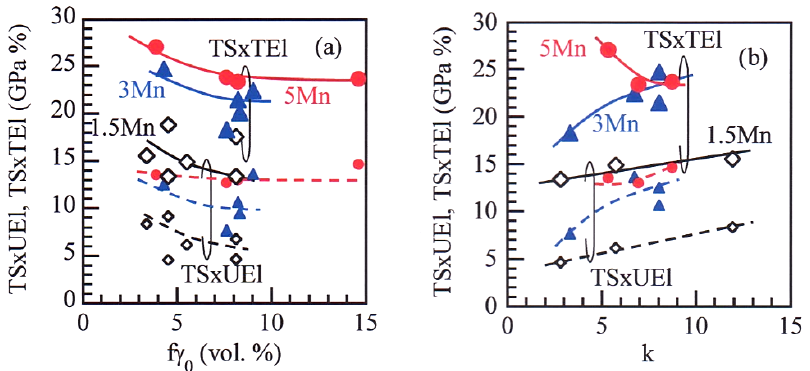
Figure 12. Relationships between TS × TEl and TS × UEl and ( a ) initial volume fraction ( f γ 0 ) and ( b ) strain-induced transformation factor ( k ) of retained austenite in the 1.5Mn ( ◇ ), 3Mn ( ▲ ), and 5Mn (●) steels . The IT temperatures are between M s and M f − 100 C.